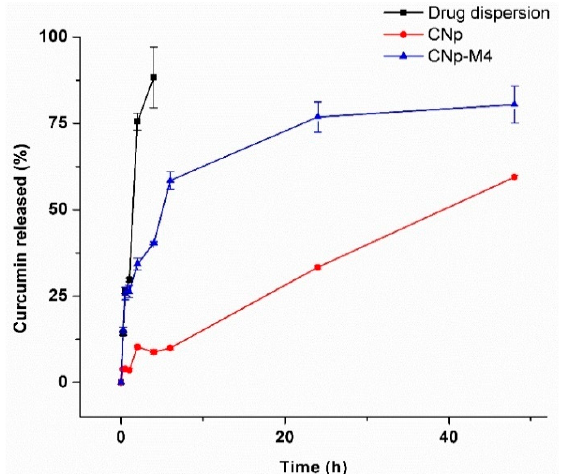
Figure 7. Release profile of curcumin from the drug dispersion, CNp and CNp-M4 membrane in PBS pH 7.4 (0.1 M, Pluronic ® F-127 2% w / v ) at 37 °C. Each point represents the mean ± SE, n = 3. Table 3. Squared of the correlation coe ffi cient (R 2 ) and coe ffi cients obtained after the linear regression of release data from CNp and CNP-M4 utilizing four mathematical